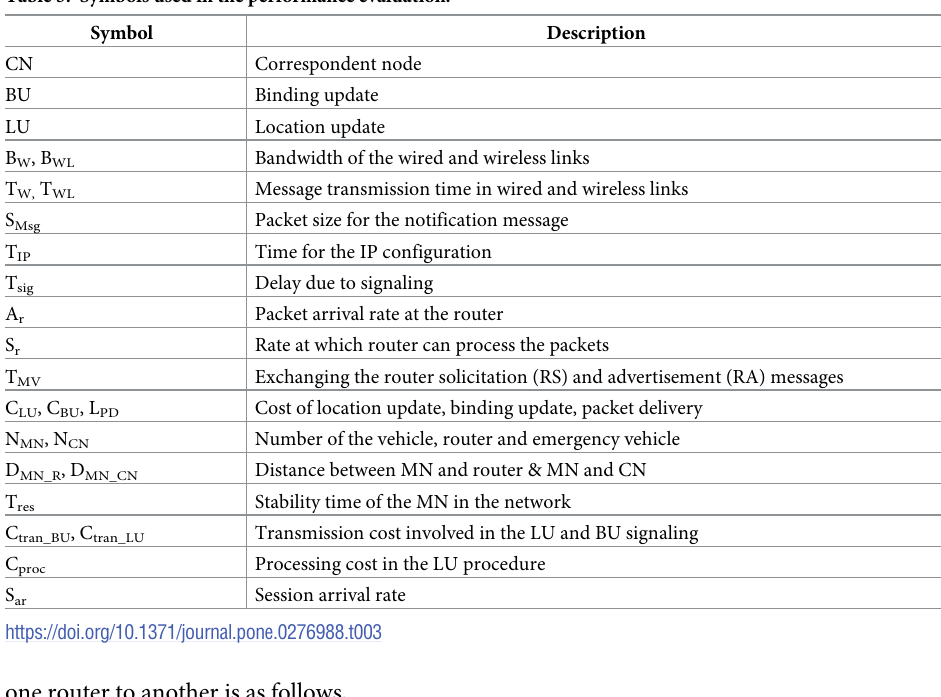
Table 3. Symbols used in the performance evaluation.